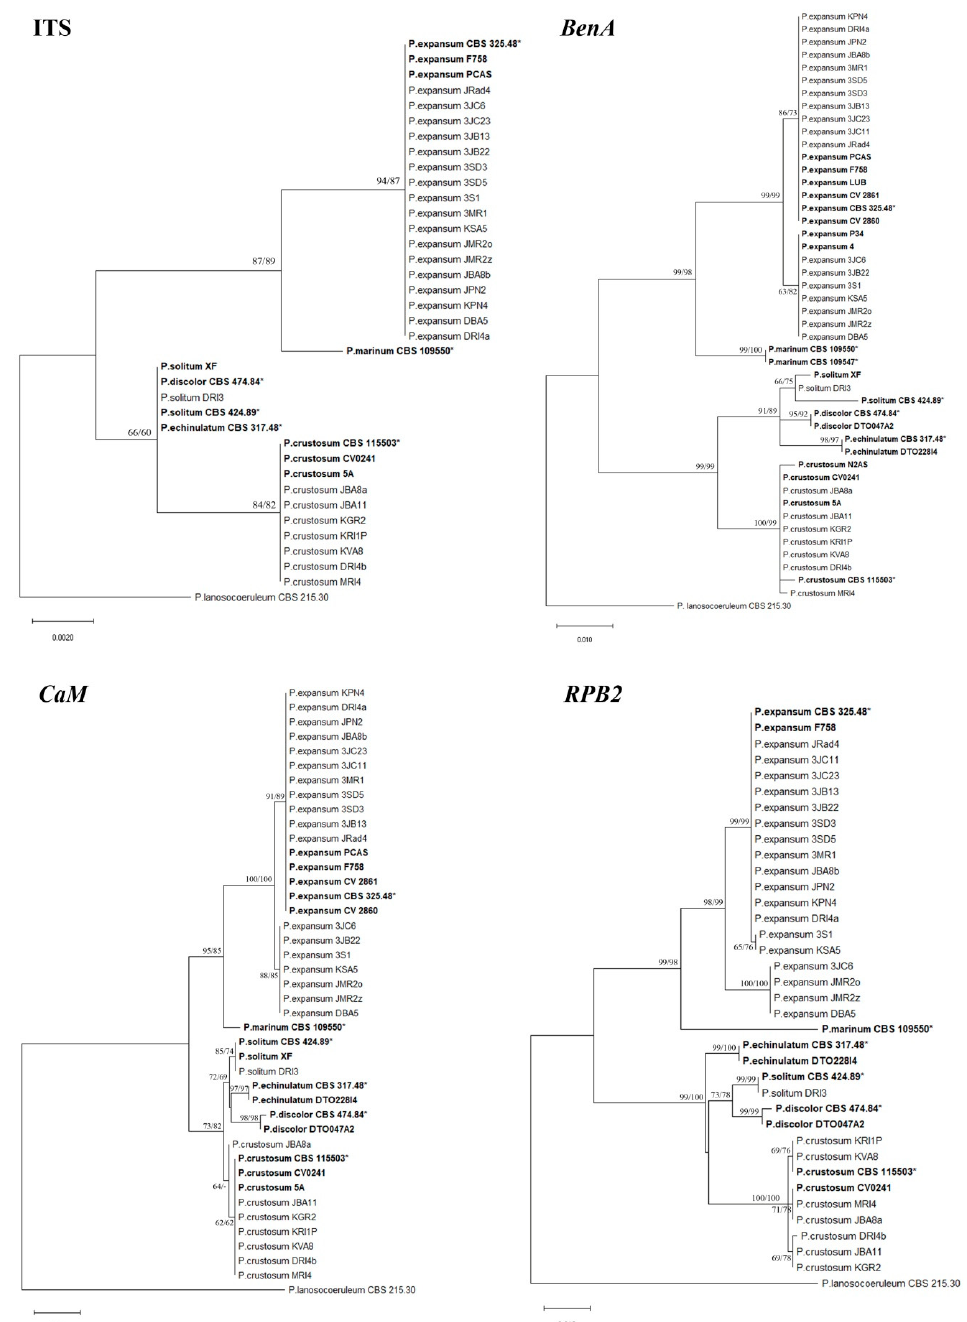
Figure 6. Phylogenetic relationships amongst Penicillium expansum , P. crustosum , and P. solitum based on ITS, BenA , CaM , and RPB2 . Bootstrap values larger than 60 of the Maximum Likelihood (ML) and Maximum Parsimony (MP) analysis are shown above or below the branches. The tree is rooted with Penicillium lanosocoeruleum as an outgroup. Numbers on the branches present bootstrap values obtained for 1000 replicates. Bolded isolates are reference isolates, and bolded isolates with * are ex-type isolates.